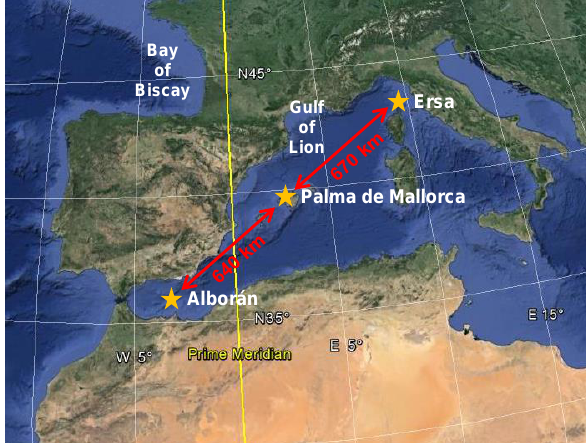
Figure 1. Geographical situation of Ersa, Palma and Alborán AERONET stations in the western Mediterranean Basin. Credit: map adapted from Google